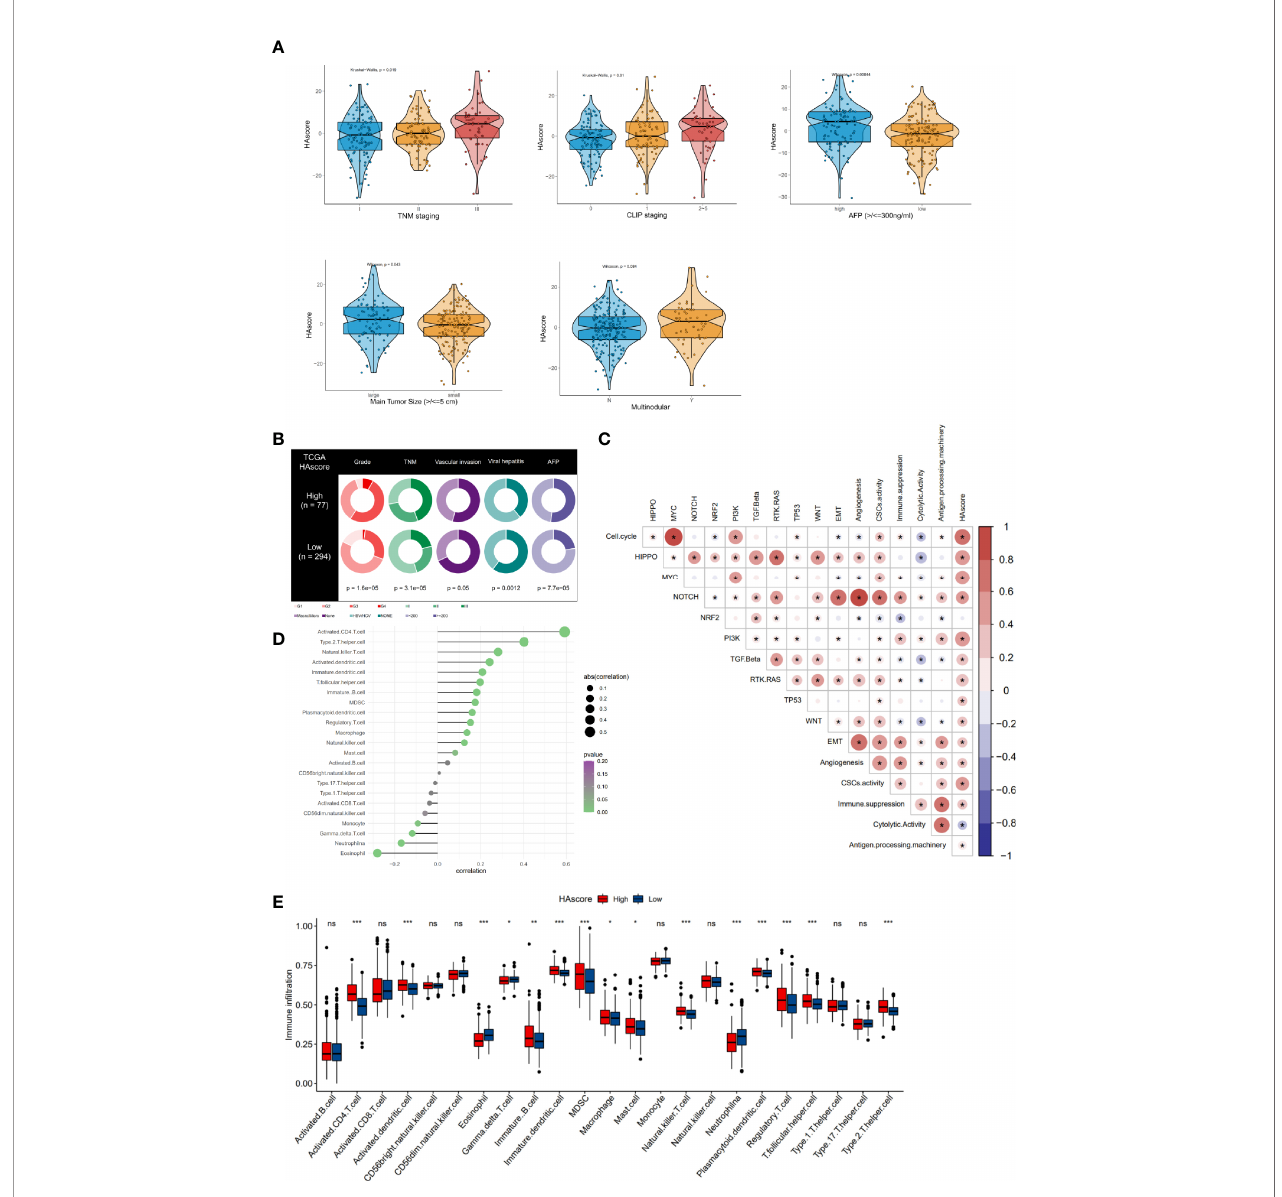
FIGURE 5 | Clinical features, molecular characteristics, and TME in fi ltrating cells of the distinct HAscore groups. (A) Difference in HAscore among distinct clinical features related subgroups in the GSE14520 cohort. The Wilcoxon test was used to test the statistical differences among clinical features related subgroups. (B) Clinical features for the high and low HAscore groups in TCGA-LIHC cohort. Chi-squared test or Fisher test was used to test the statistical differences. (C) Correlations between the HAscore and the known gene signatures in RNA-seq meta cohort using Spearman analysis. Positive correlation is marked with red and negative correlation with blue. The asterisks represent the statistical P value (* P < 0.05). (D) Correlations between HAscore and TME in fi ltrating cell abundance in RNA-seq meta cohort using Spearman analysis. The circle size and x-coordinates describe the correlation coef fi cient. The color of the circle is scaled by P value. (E) Boxplot of each TME in fi ltrating cell abundance for high and low HAscore groups in the RNA-seq meta cohort. The statistical differences among the HAscore groups were tested by the Kruskal – Wallis test. (* P < 0.05; ** P < 0.01; *** P < 0.001; ns, non-signi fi